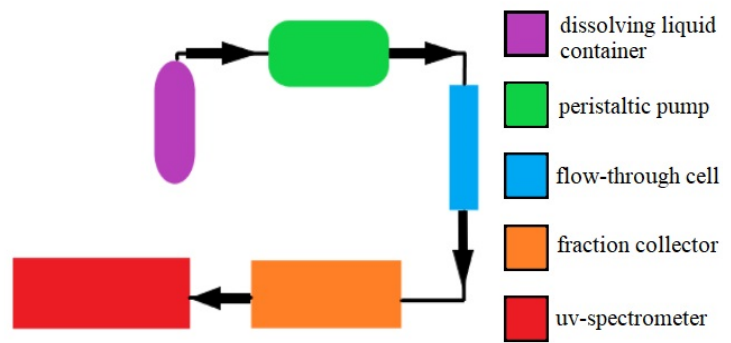
Figure 7. Measurement with flow ‐ through cell.